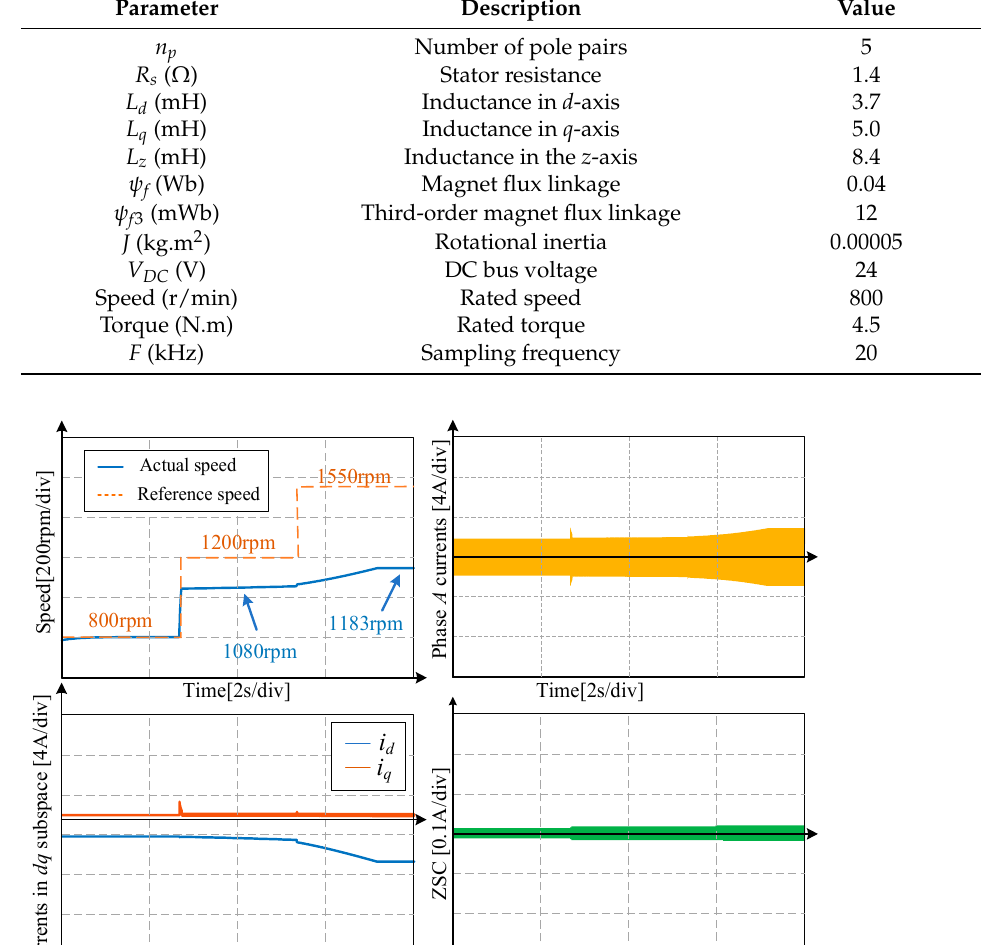
Table 1. Parameter of series-winding PMSM.